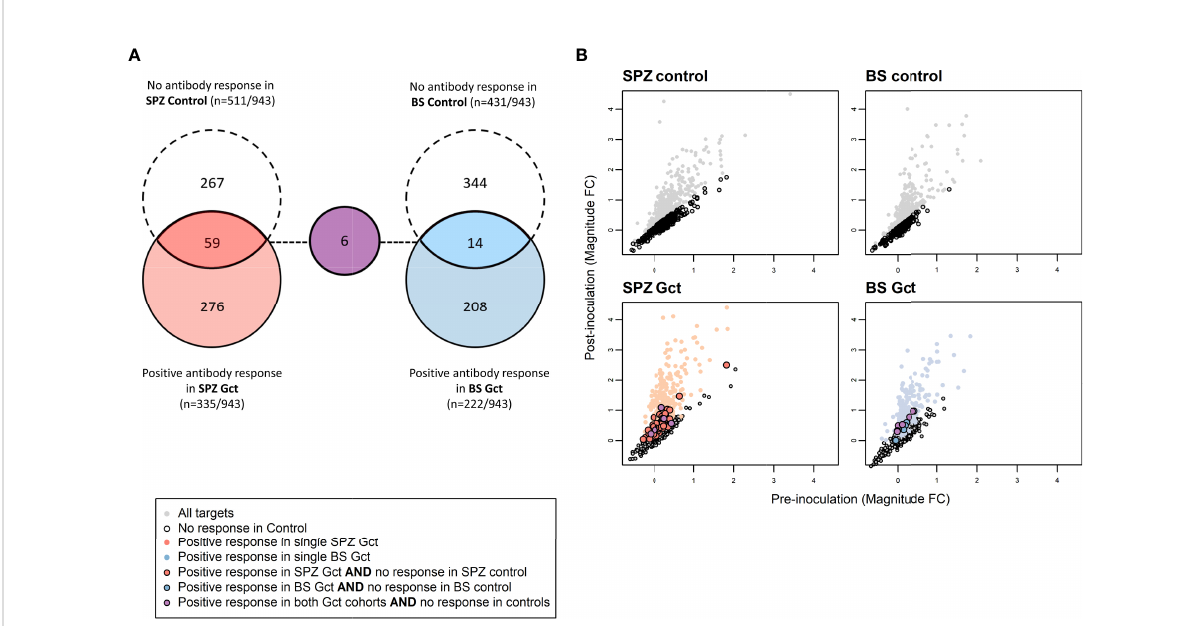
FIGURE 4 Differences in antibody response to microarray targets associated with gametocyte exposure. (A) Array targets demonstrating minimal response (<7.5% increase in the mean magnitude of response between pre- [day 0] and post- [day 35] inoculation timepoints) in the control CHMI cohorts are shown in red for SPZ Control (sporozoite inoculum) and blue for BS Control (asexual inoculum). Array targets demonstrating a positive response (>7.5% increase in the mean magnitude of response between pre- [day 0] and post- [day 36] inoculation timepoints) in the control CHMI cohorts are shown in dashed circles for each cohort, with overlap representing those targets with minimal response in control and positive response in Gct cohorts. (B) Axes show pre- and post-inoculation mean magnitude of response (log2 MFI ratio) to each target on the array. Mean magnitude for each target is represented by a single marker. Grey markers are those with increased responses after inoculation in the Control cohorts. Red and blue markers are as in (A) Targets with responses only in the CHMI Gct cohorts are outlined in